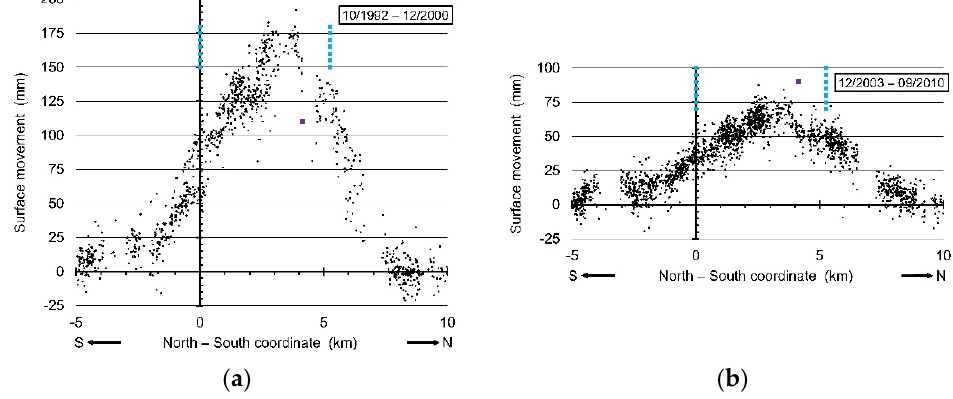
Figure 1. Variation of the uplift along a north–south transect, above the coal mine of Eisden, Belgium: ( a ) From October 1992 through December 2000; ( b ) From December 2003 through September 2010. Along this transect, the mining took place between 0 and 5.25 km (blue square dotted lines). The position of the central shafts is indicated by purple square (north–south coordinate of 4.1 km).